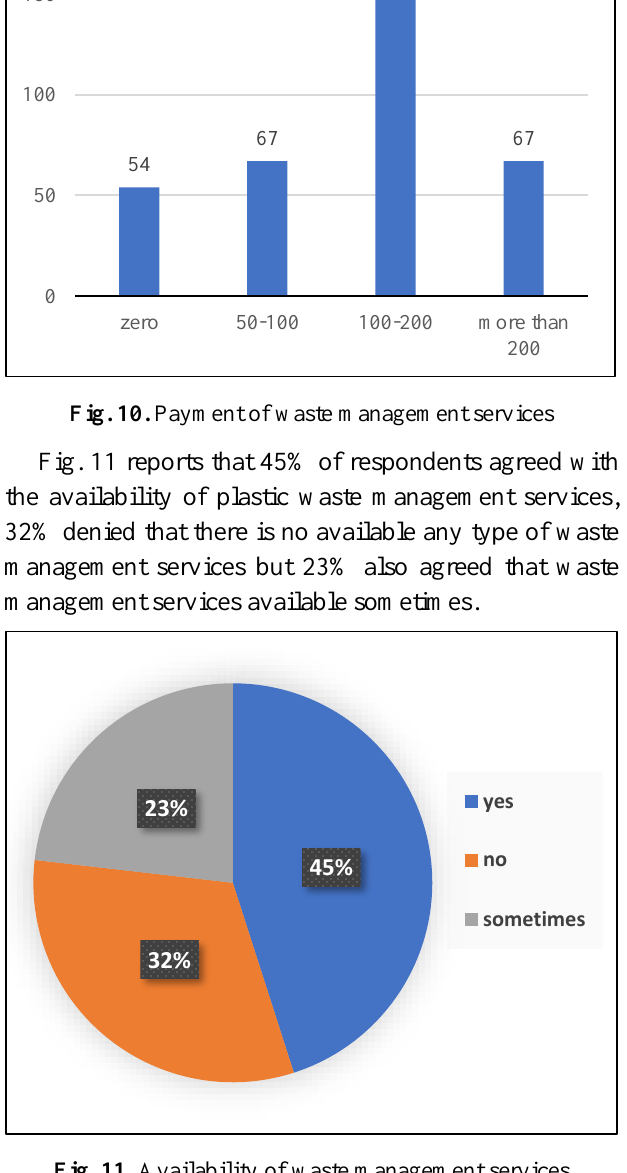
Fig. 11. Availability of waste management